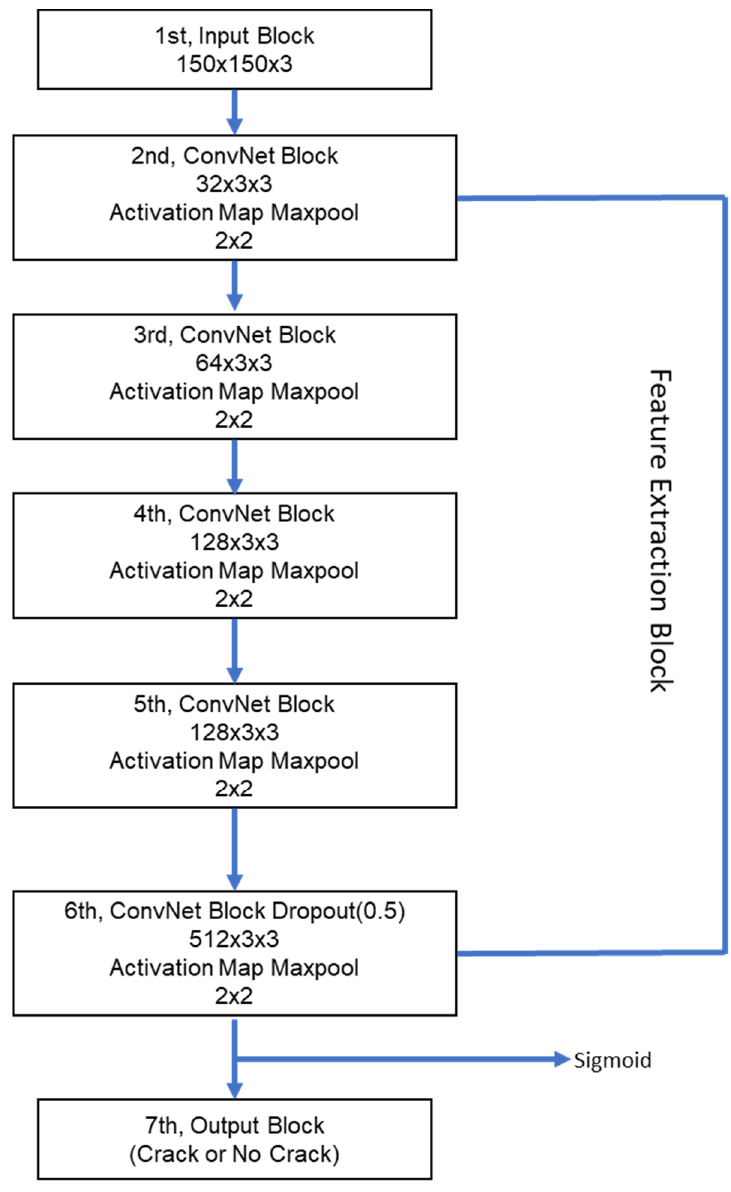
Figure 1. Proposed network architecture.